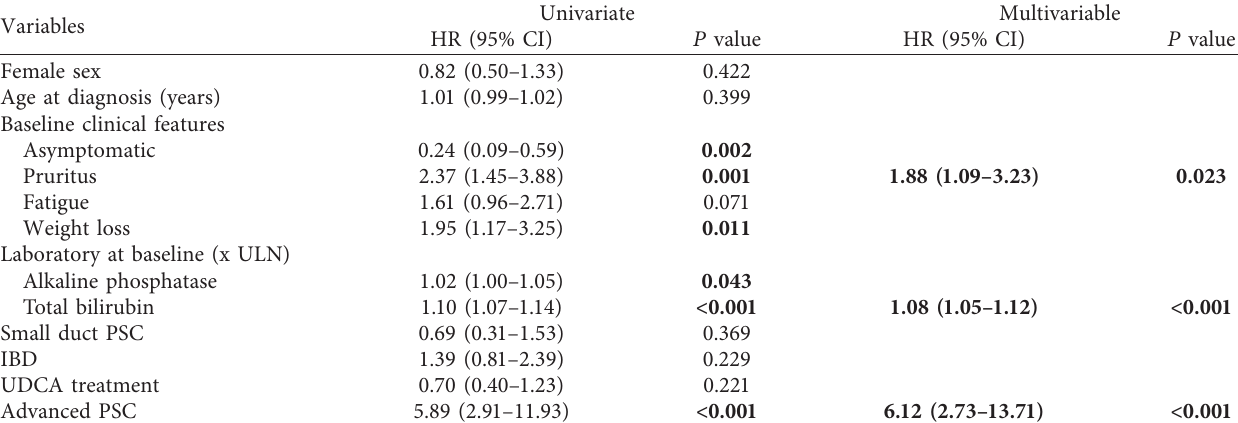
Table 2: Factors associated with adverse outcomes, either liver transplantation or death, in patients with PSC.